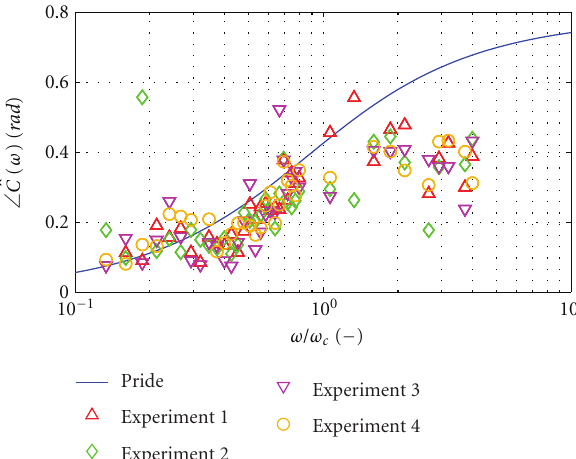
Figure 8: Phase values of the dynamic SP coe ffi cient. Theory of Pride [29] versus measurements, using the parameters as shown in Table 1 and assuming σ ( ω ) = σ 0 . Experiments 1–4 denote repeated experiments at di ff erent